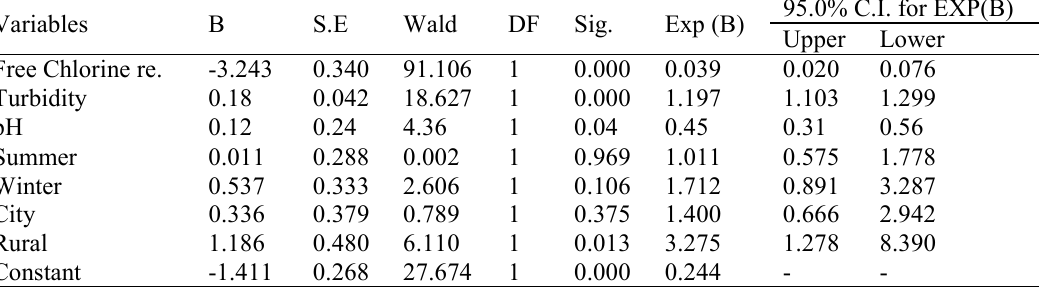
Table 5. Logistic regression analysis of microbiological parameters Variables B Free Chlorine